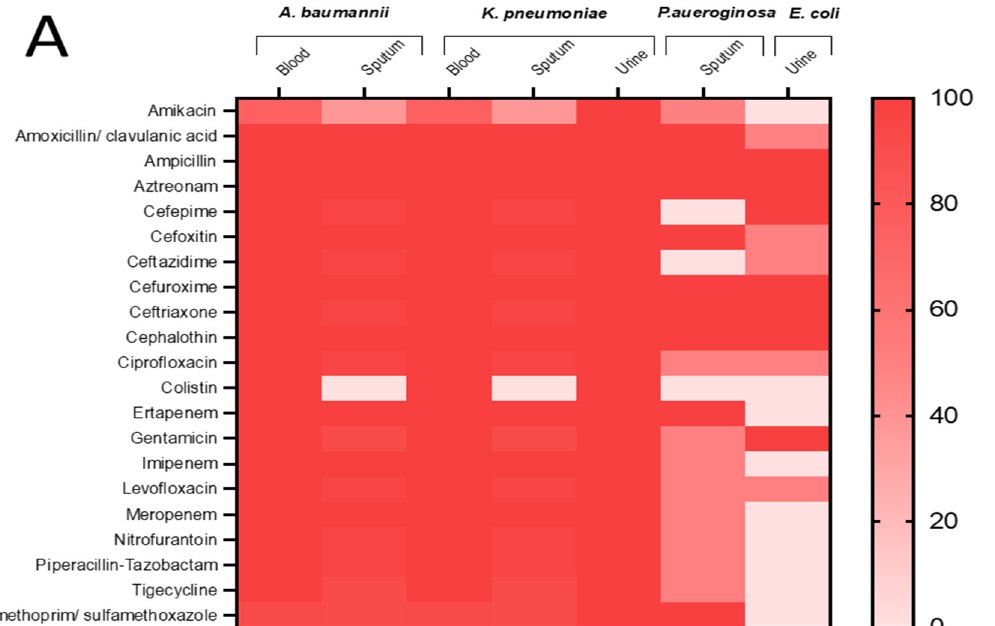
Figure 3. Heat maps representing the percentages of antibiotic resistant bacteria in positive cultures isolated from samples collected from COVID-19 patients in ( A ) ICU and ( B ) non-ICU care. 4. Discussion The ongoing COVID-19 pandemic has led to over 330 million cases and 5 million deaths worldwide up to today (23 January 2021) [22]. Admission to the ICU for at least a quarter of COVID-19 patients is highly likely because of severe respiratory complications [23]. ICU patients are more prone to secondary bacterial infections associated with pro- longed ICU stay and increased risk of death [10]. This study therefore aimed to investigate